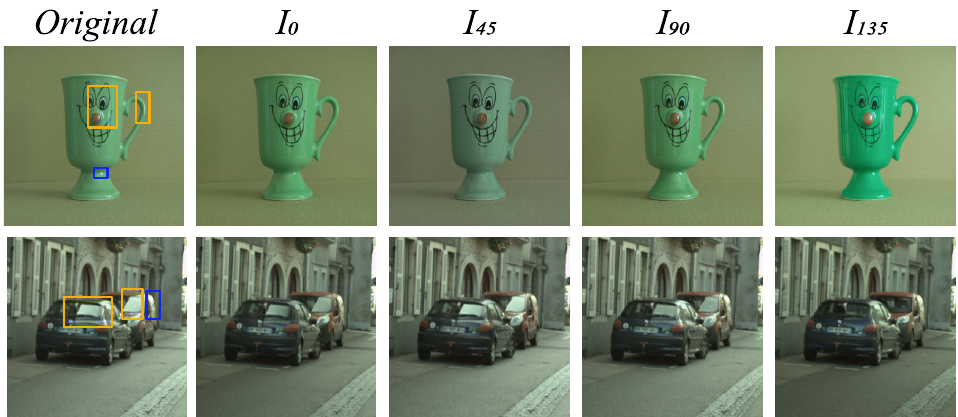
Figure 3. Variation in specularity with the variation of polarisation angle (orange areas) in uncon- trolled environments. Note that unpolarised light causes specular reflection regardless of polarisation filter angle (blue